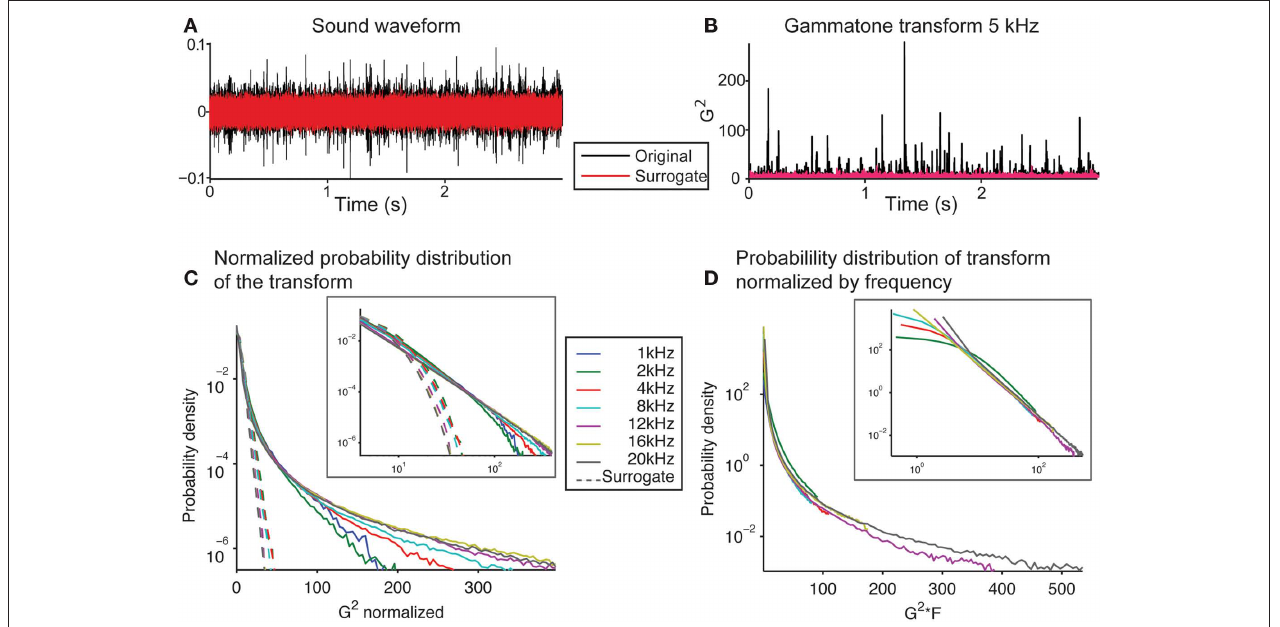
revealed for the original recording. The histogram for the surrogate signal follows a log-linear relation, which is expected of a Gaussian signal. (Inset depicts the same data on log–log scale). (D) Histogram of the non-normalized power of the gammatone transform of the original recording and the surrogate signal at frequencies between 1 and 20 kHz, scaled by the center frequency of the transform. Note that these histograms overlap closely for the full range of frequencies for large values. (Inset depicts the same data on a